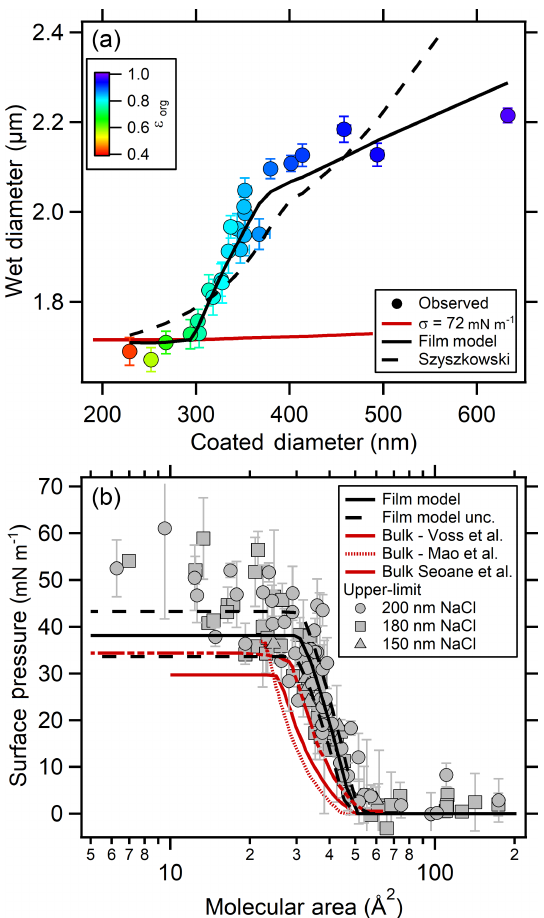
Figure 2. (a) Wet diameter (at RH = 99.93%) vs. dry diameter of 200nm NaCl particles coated with varying amounts of oleic acid. The red line is the calculated droplet size, assuming σ = 72mNm − 1 , independent of coating amount; and the black and dashed black lines are film model and Szyszkowski model fits to the data, respectively. The error bars correspond to the 95% confidence interval for mode of the wet diameter distribution. The data points are colored by organic volume fraction ( ε org ). (b) Upper-limit esti- mates (grey points) and film model estimates (black lines) for sur- face pressure as a function of molecular area for various NaCl seed sizes (circles = 200nm, squares = 180nm, and triangles = 150nm) and RH. Error bars on individual points and the film model fit (dashed black lines) are based on the precision in RH. Macroscopic solution measurements (red lines) adapted from Voss et al. (2007), Mao et al. (2013), and Seoane et al. (2000) are included for refer-